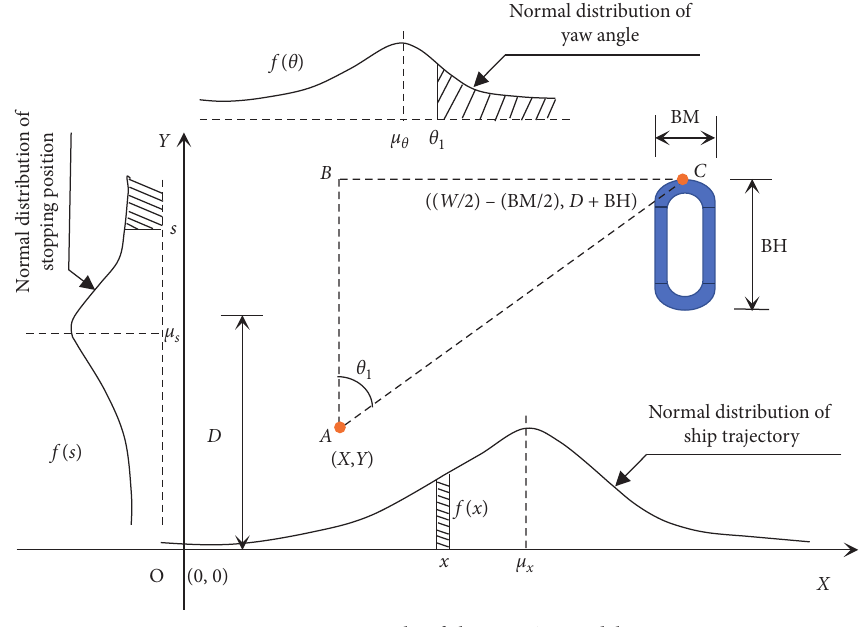
Figure 3: Principle of the KUNZI